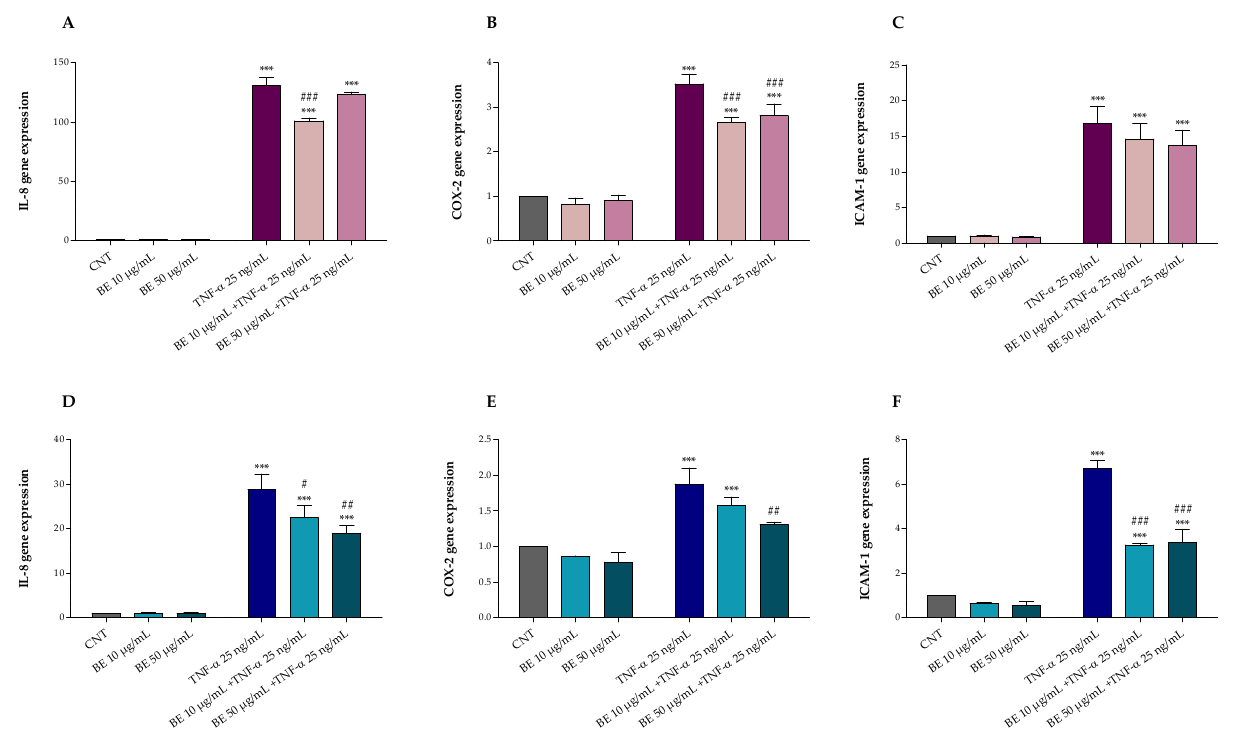
Figure 3. Effects of 1 h pre-treatment with bee pollen extract (BE 10 and 50 µg/mL) on HT-29 exposed 4 h ( A – C ) and 24 h ( D – F ) to 25 ng/mL TNF- α : ( A , D ) IL-8, ( B , E ) COX-2, and ( C , F ) ICAM-1 (Real-Time qPCR). One-way ANOVA with Dunnett’s Multiple Comparison test: * significantly different from control (CNT), *** p < 0.001; # significantly different from TNF-α: # p < 0.05, ## p < 0.01, ### p < 0.001.